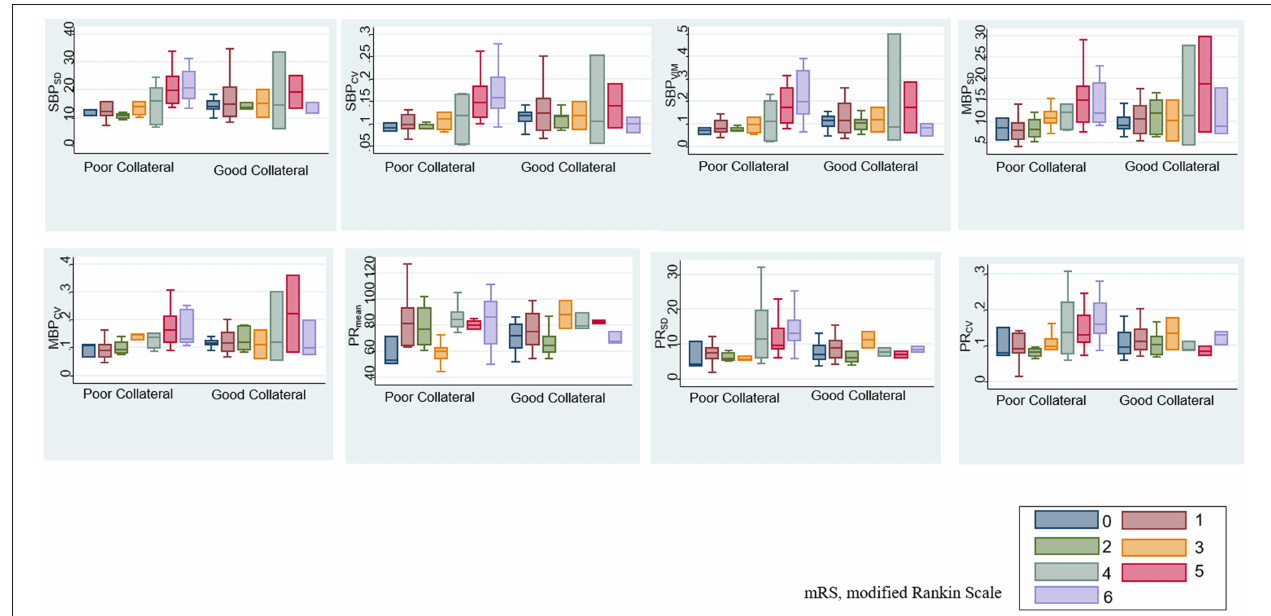
FIGURE 3 | Association between BPV parameters and modified Rankin scale (mRS) based on baseline collateral